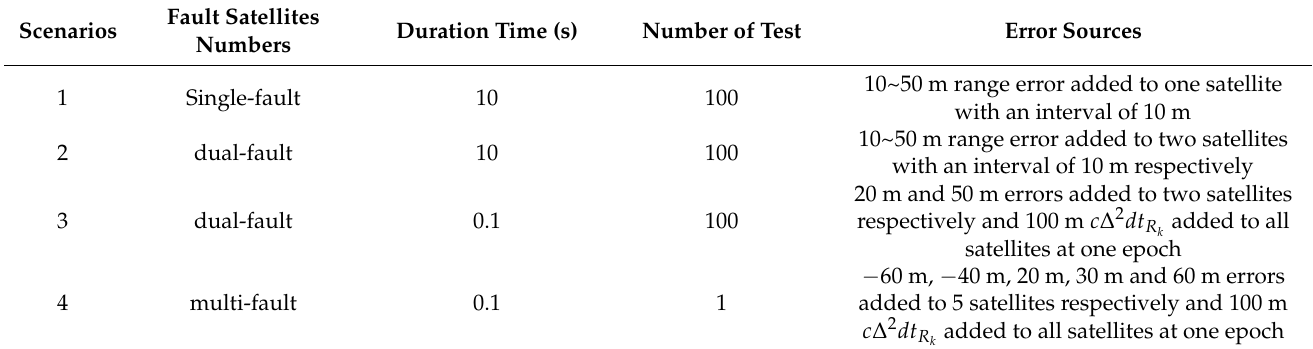
Table 6. An example of windowing results in Scenario 3.